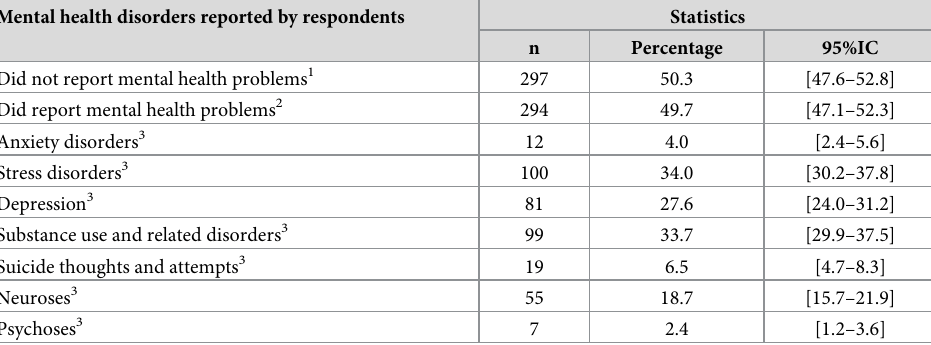
Table 4. Distribution of mental health cases reported by respondents in the household survey (n =